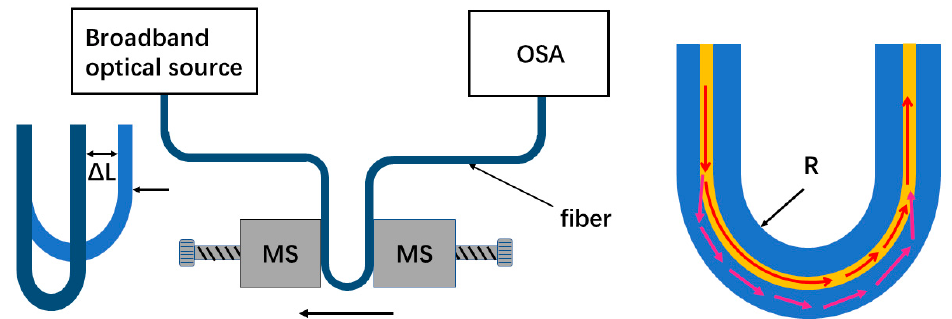
Figure 1. The schematic of the experimental setup and the bending fiber structure.